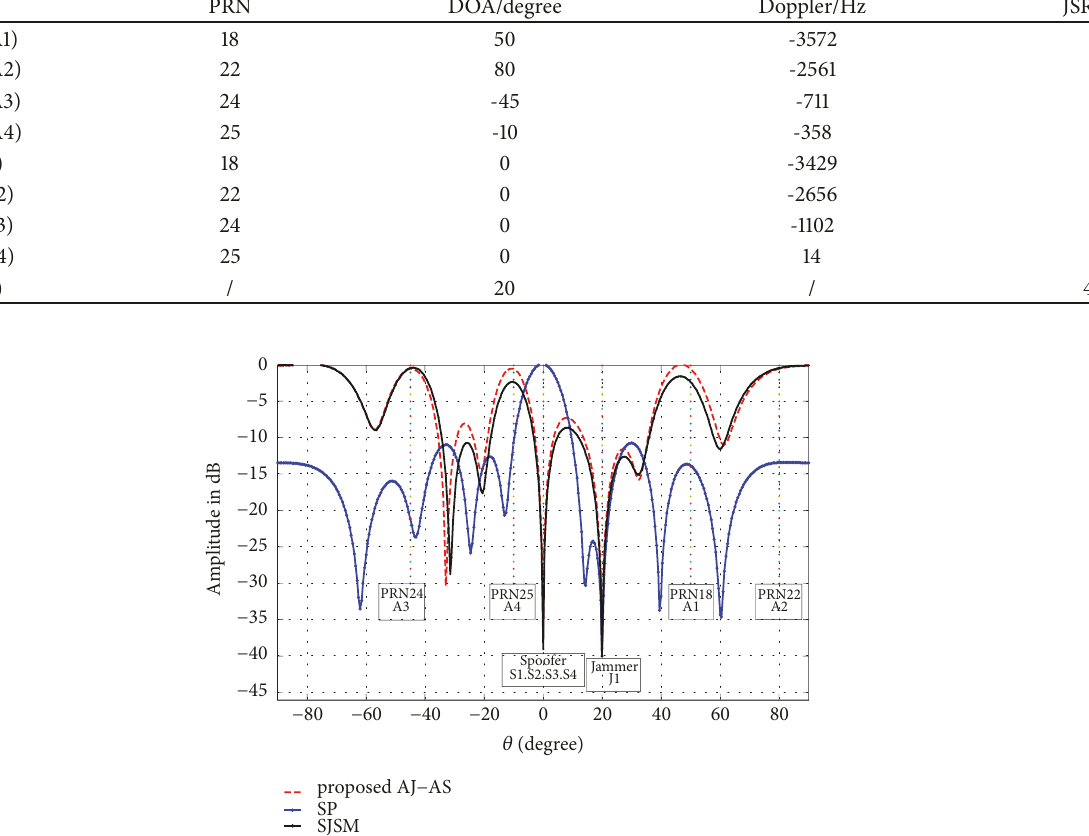
Figure 3: Adaptive array direction